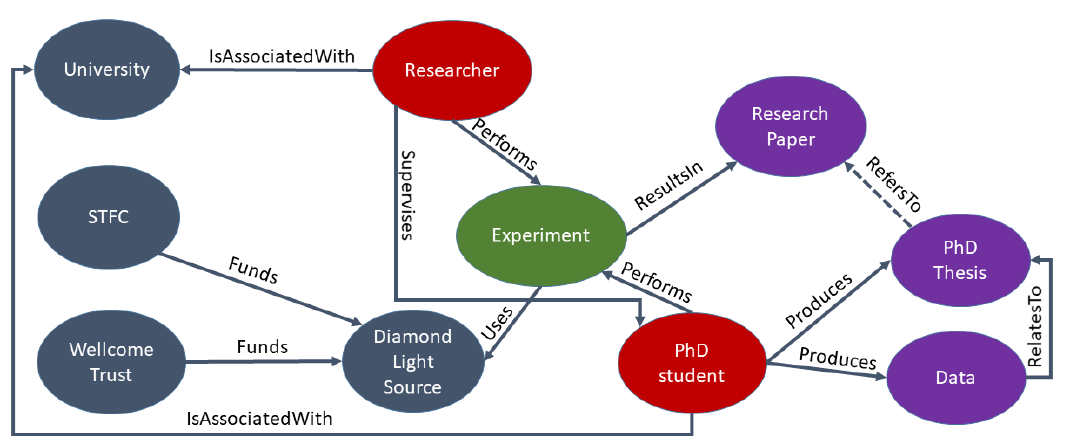
Figure 1. A schematic of PhD research performed on the Diamond Light Source [6], and the artefacts produced from it.